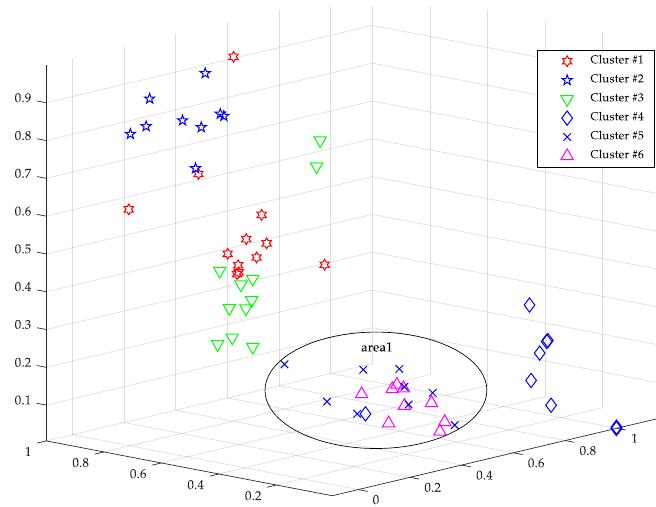
Figure 7. Clustering results of CCDBSCAN method ( Eps = 0.96, MinPts = 3). Table 4. Confusion matrix of CCDBSCAN analysis